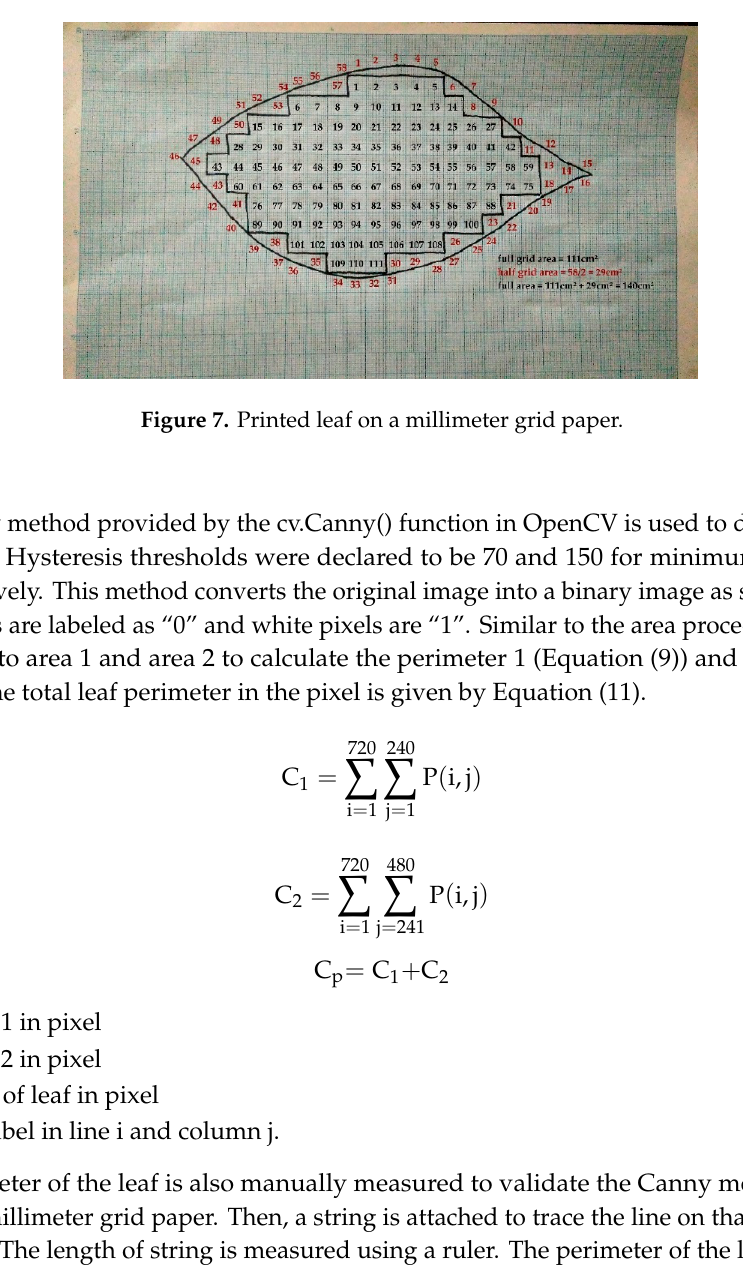
Figure 6. ( a ) Full area of image and ( b ) area 1 and area 2 for leaf image.